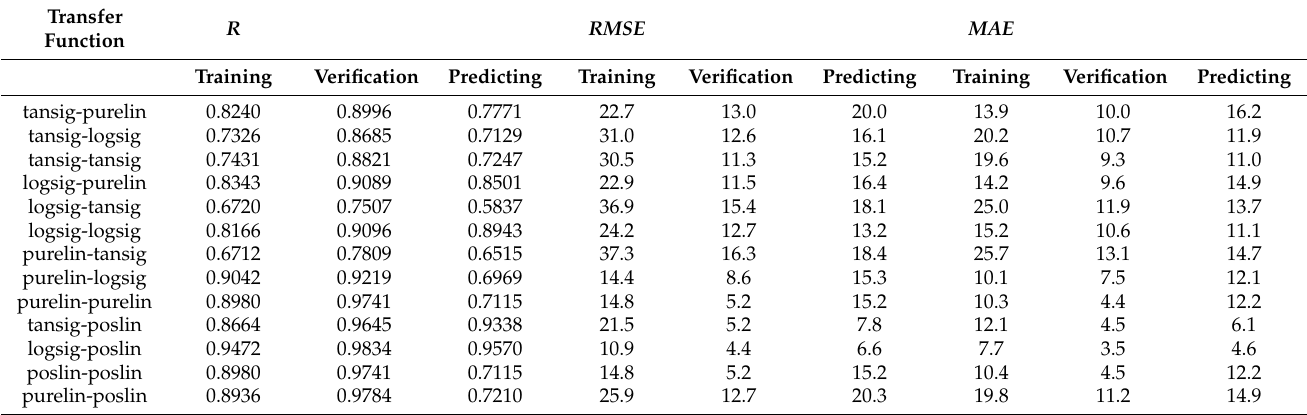
Table 6. Comparison of R , RMSE ( µ g/m 3 ), and MAE ( µ g/m 3 ) between various transfer